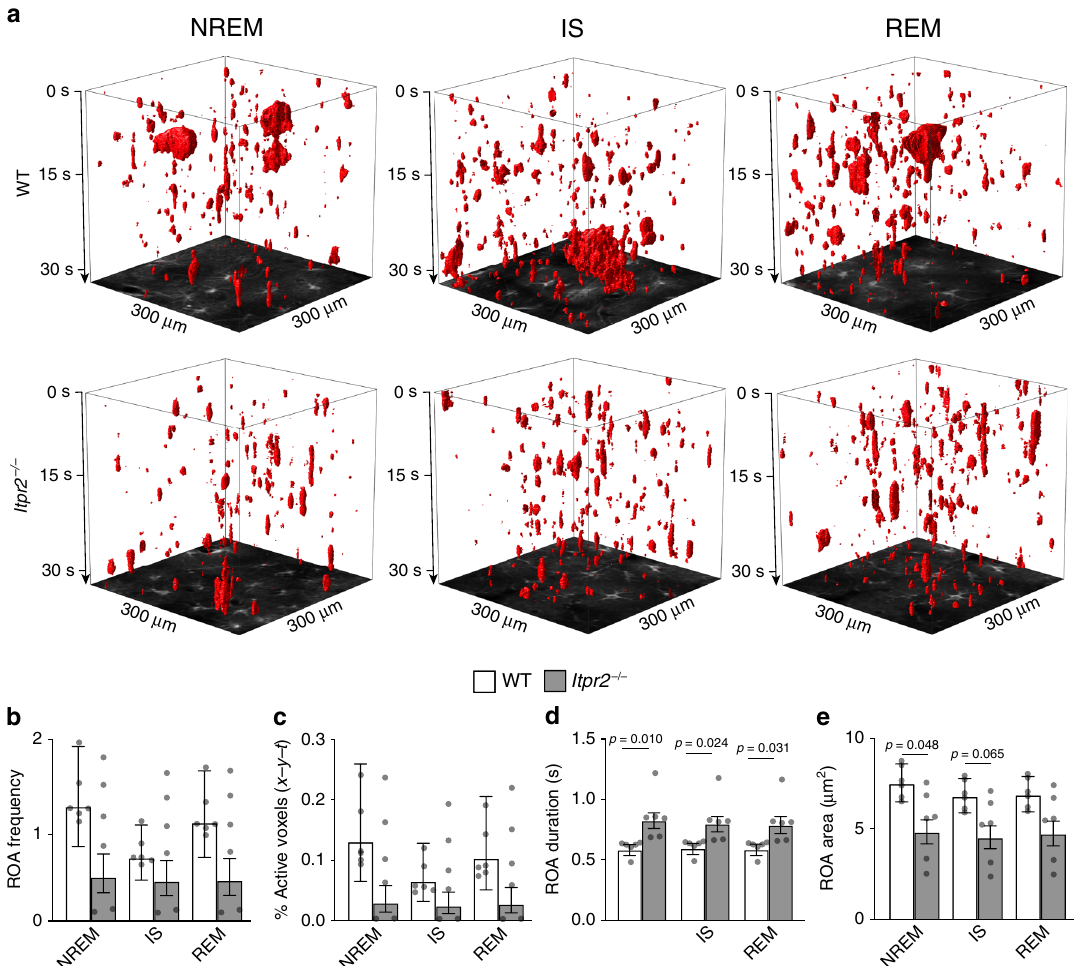
Fig. 7 Astrocytic Ca 2 + signaling during sleep is dependent on the IP 3 pathway. a Representative x-y-t rendering of ROAs during NREM, IS, and REM sleep in WT and Itpr2 − / − mice. b – e Mean ROA frequency expressed as number of ROAs per 100 μ m 2 per minute ( b ), the percentage of active voxels ( x-y-t ) ( c ), ROA duration (s) ( d ), and ROA area ( μ m 2 ) ( e ) during NREM, IS, and REM sleep in WT and Itpr2 − / − mice. Data represented as estimates ± SE and p -values (two-sided test, no adjustment for multiple comparisons) derived from linear mixed effects models statistics, n = 6 mice, 196 trails for WT, n = 6 mice, 100 trials for Itpr2 − / − . For details on statistical analyses, see “ Methods. ” See also Supplementary Fig.